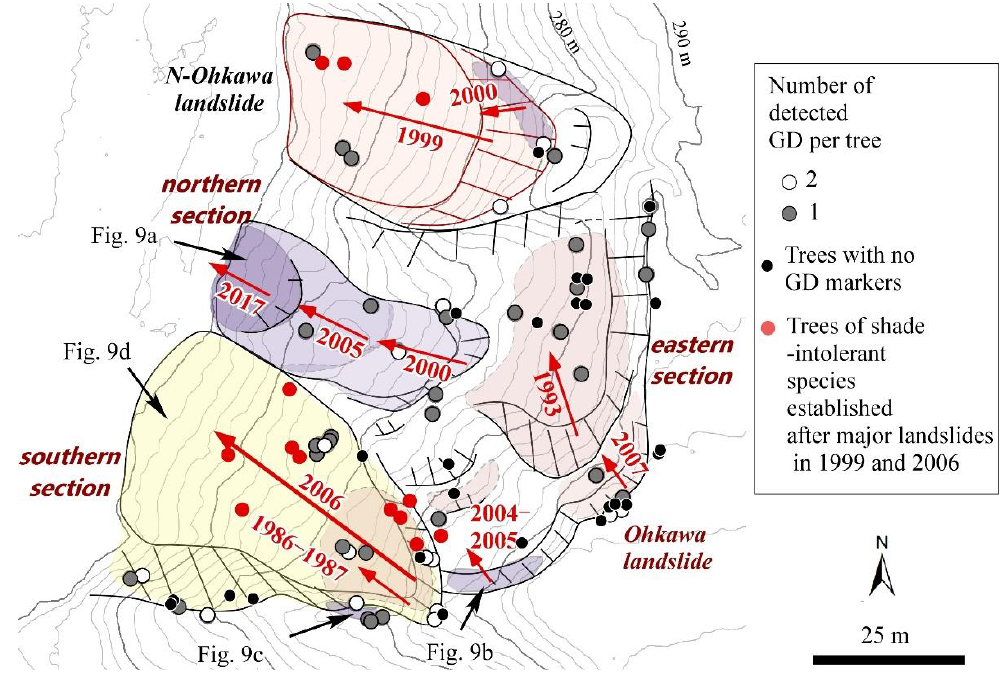
Figure 8. Summary of past landslide events in the study area and distribution of detected GDs and trees established after the landslide events.